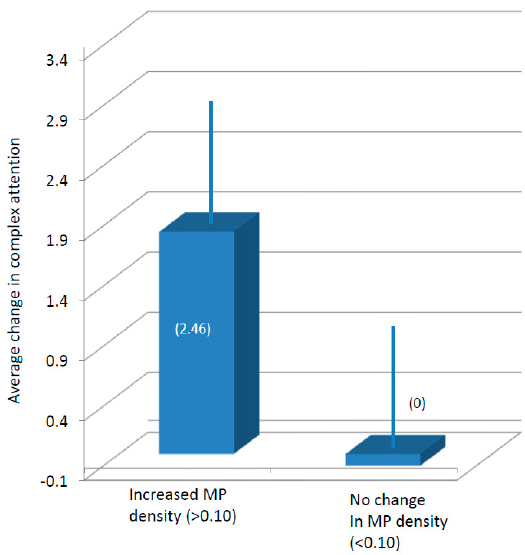
Figure 3. Average (and standard error of the mean (SEM)) change in complex attention segregated according to changes in macular pigment (MP) density.